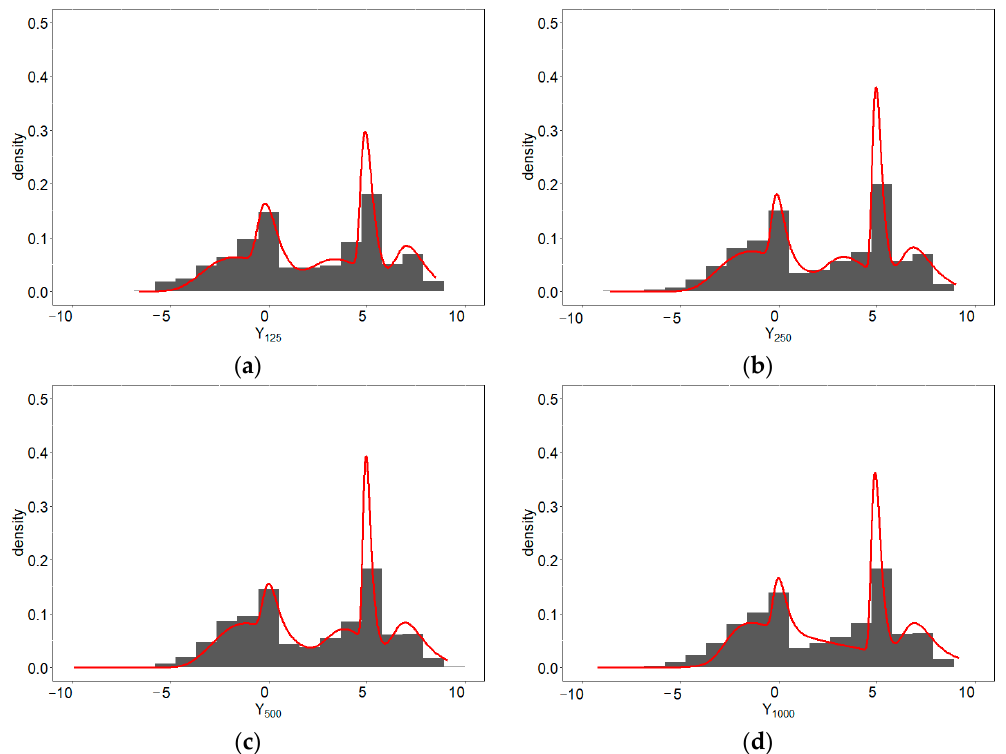
Figure 5. Histograms and predictive densities for the five-component EV-I mixture distribution with ( a ) 125, ( b ) 250, ( c ) 500, and ( d ) 1000 samples per component.